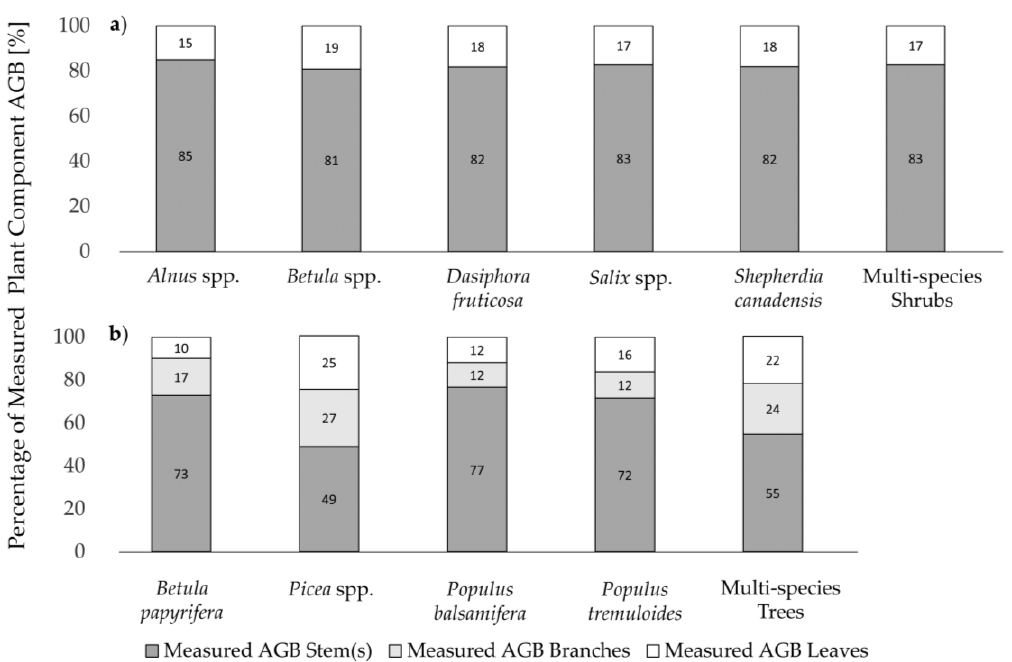
Figure 2. Measured aboveground biomass [%] per plant component for common boreal ( a ) shrub and ( b ) short-stature tree